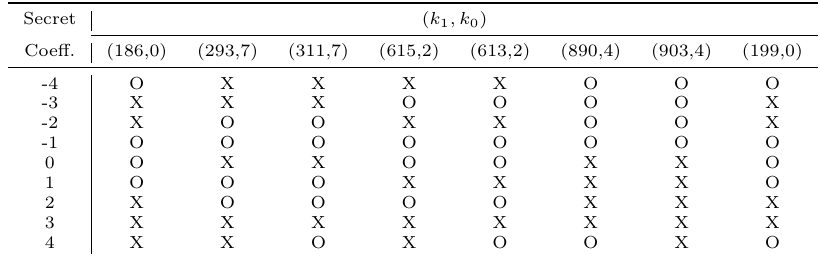
Table 9: Chosen pairs of ( k 1 , k 0 ) to determine s [ i ] based on m [ i ] for Saber with [8 , 4 , 4] 2 extended Hamming codes. (X: m [ i ] = 1; O: m [ i ] =